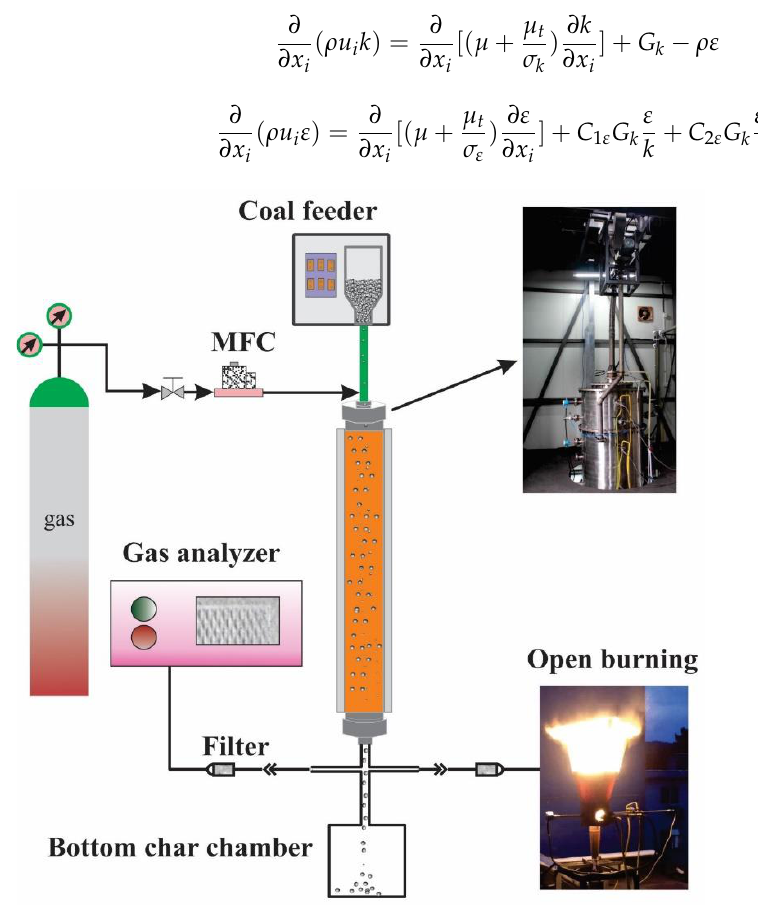
Figure 1. Schematic diagram of the drop tube gasifier.